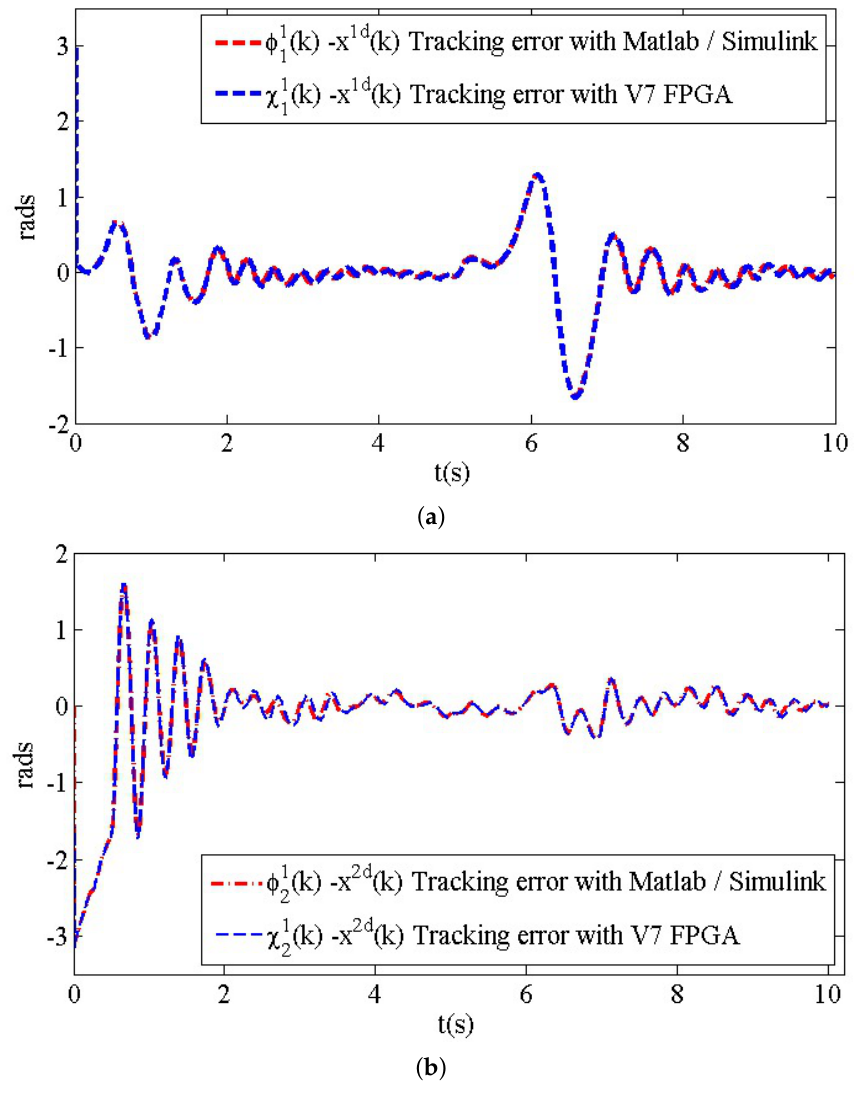
( k ) and ( b ) for z 1 ( k ) . 2 1